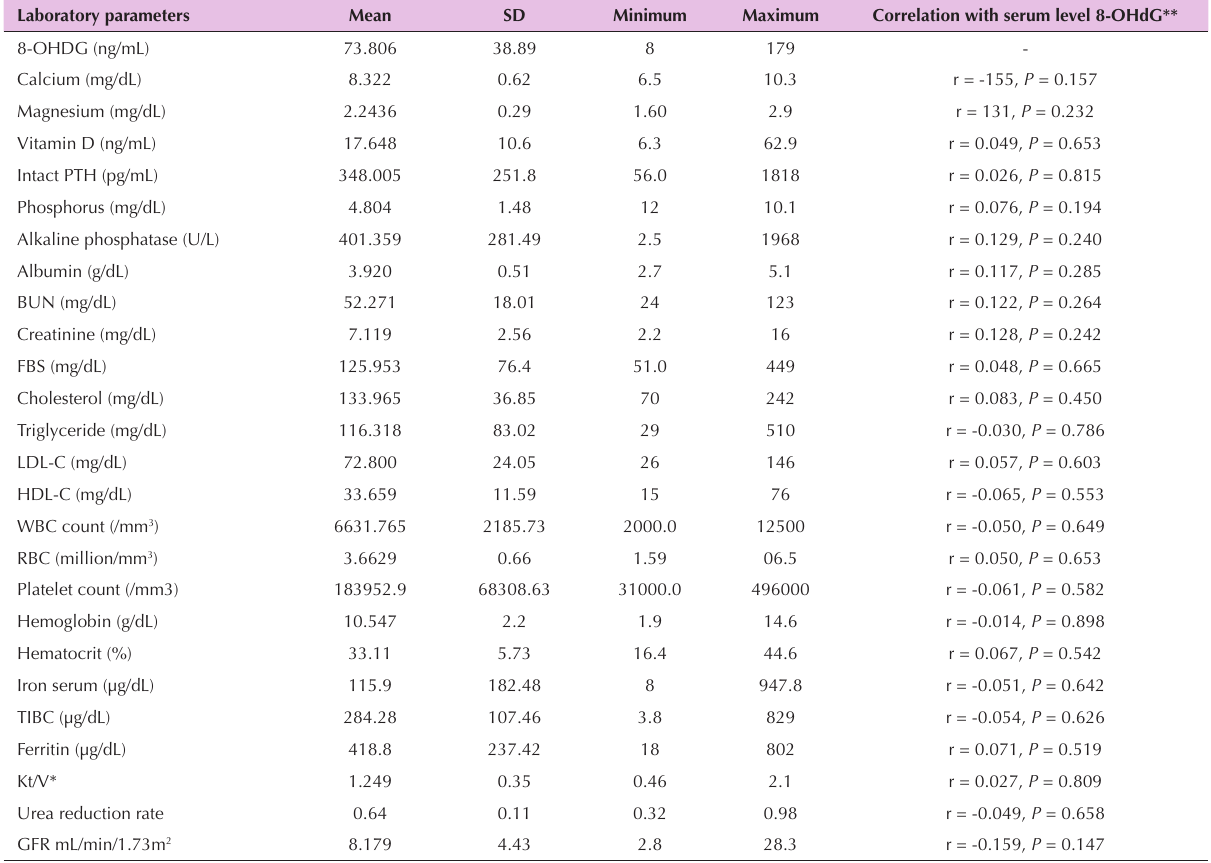
Table 3. Mean, standard deviation (SD), minimum and maximum level of laboratory parameters in the studied patients and its relationship with 8-OHDG serum